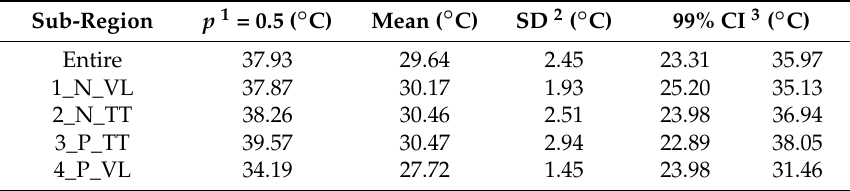
Figure 5 . ( a ) The orthomosaic image of surface temperature (°C) derived from thermal imagery using Unmanned Aerial Vehicle (UAV) and classified sub-regions based on cultivars and canopy architectures; ( b ) mixture modelling in the entire site; ( c ) in the Nectarine trained to Vertical Leader (VL); ( d ) in the Nectarine trained to Tatura Trellis (TT); ( e ) in the Peach trained to TT; and ( f ) in the Peach trained to VL. Table 3. Thermal values of canopy temperature using probability modeling.